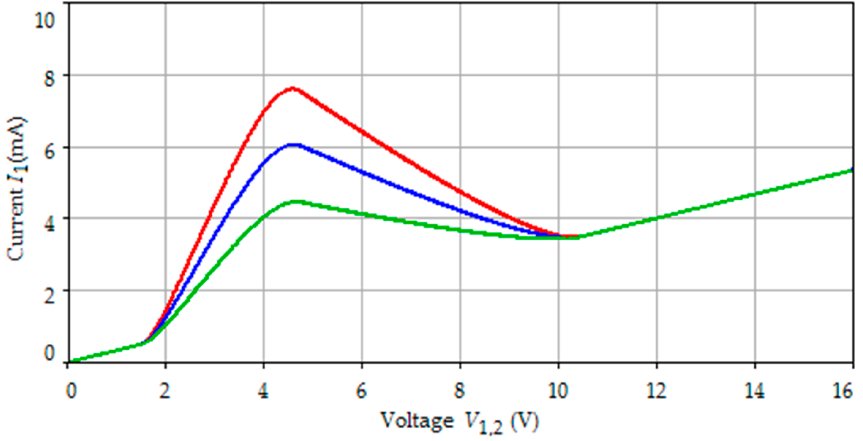
Figure 13. Current-voltage characteristics of the two-terminal NDR circuit with multiple-output Wilson current mirror; m = 0—green curve, m = 1—blue curve, m = 2—red curve.